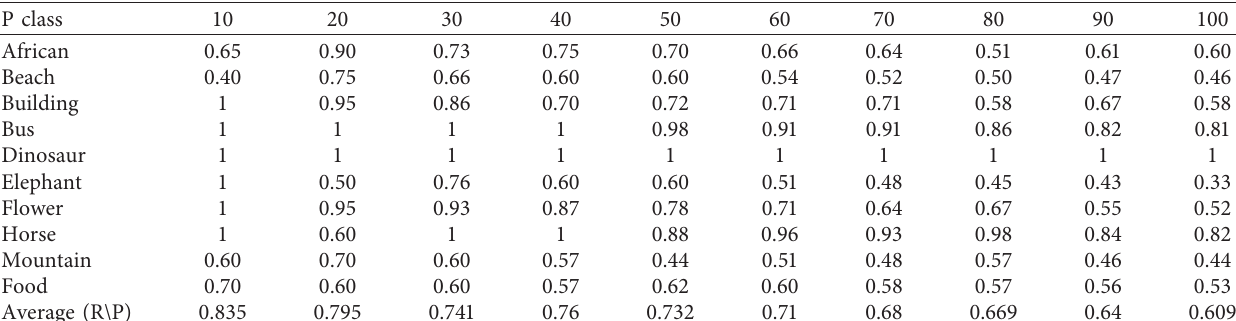
Table 8: Top 10 to 100 images are retrieved using NRLGO method for precision